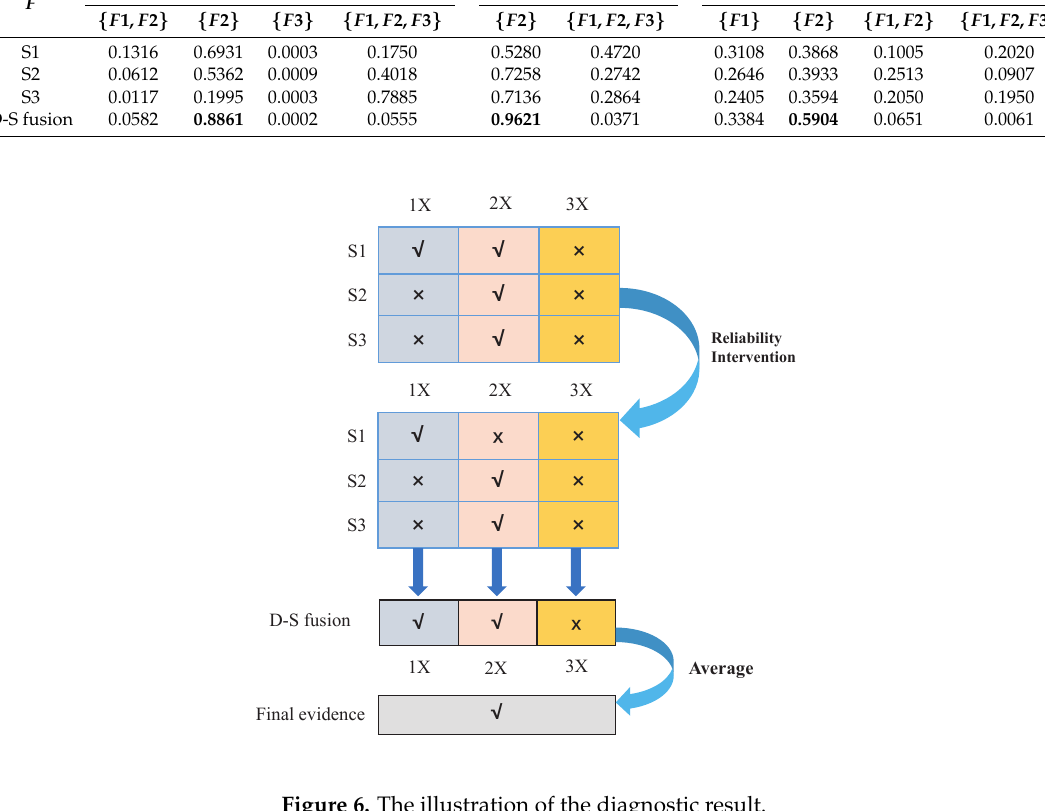
Figure 6. The illustration of the diagnostic